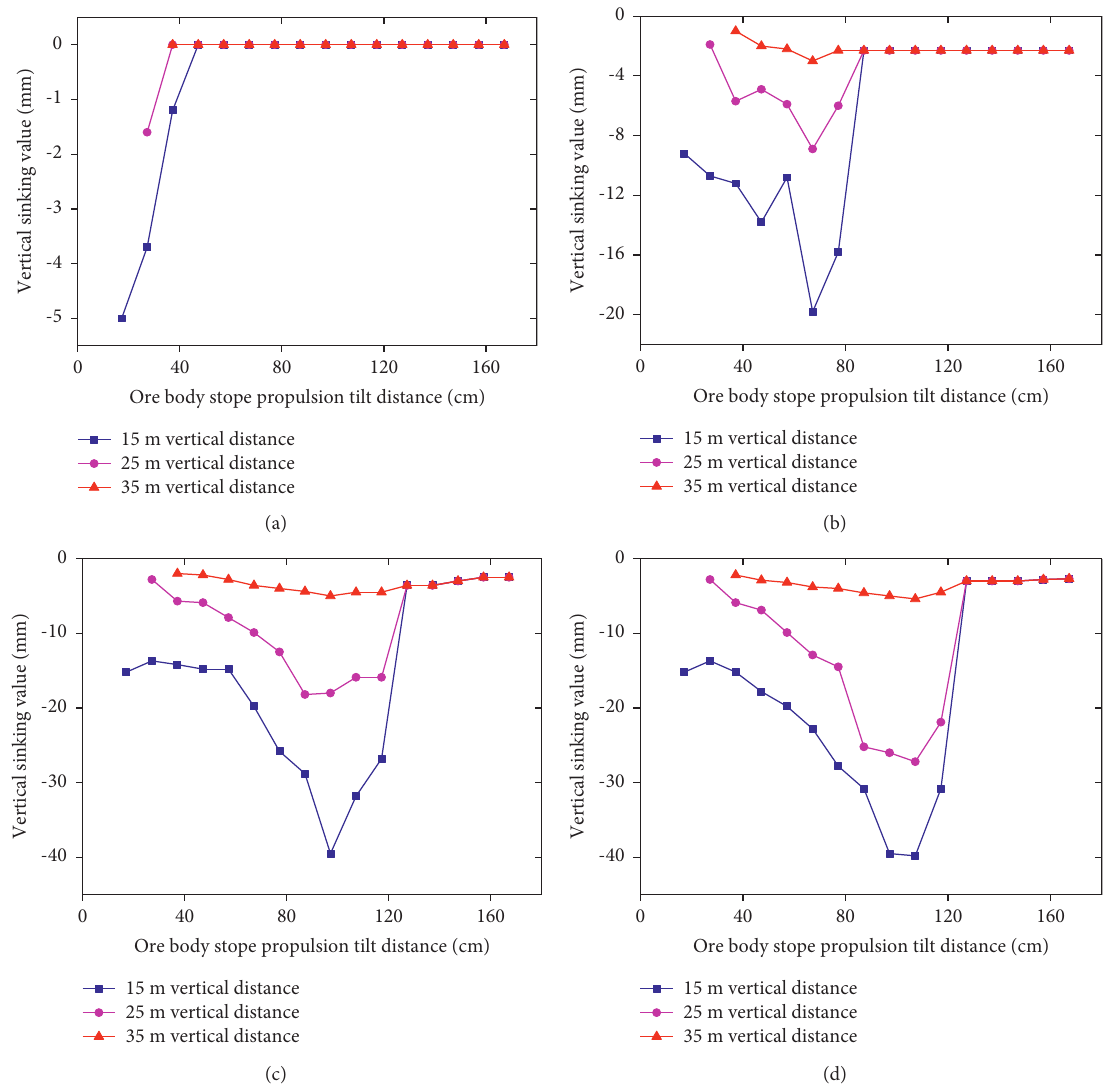
Figure 7: Surveying variation curve of vertical displacement follows each exploit progress (20 ° ). (a) Variation curve of vertical subsidence after 1-step excavation at each measuring point. (b) Variation curve of vertical subsidence after 3-step excavation at each measuring point. (c) Variation curve of vertical subsidence after 5-step excavation at each measuring point. (d) Variation curve of vertical subsidence after 6- step excavation at each measuring